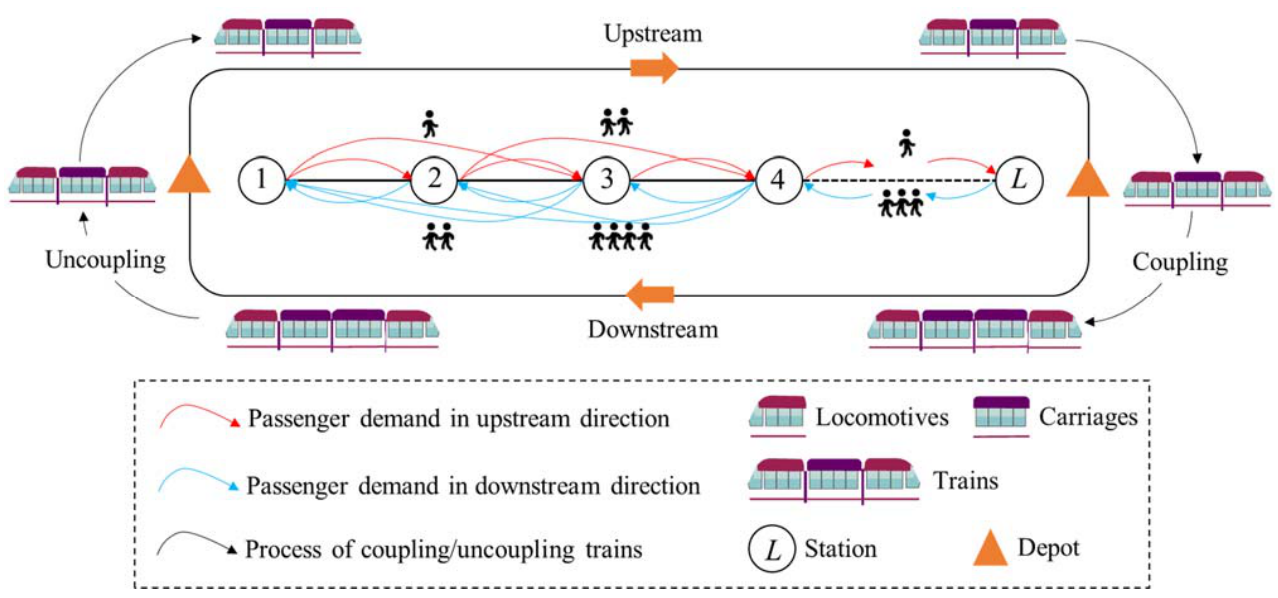
Figure 2. Illustration of the operation process in this study.